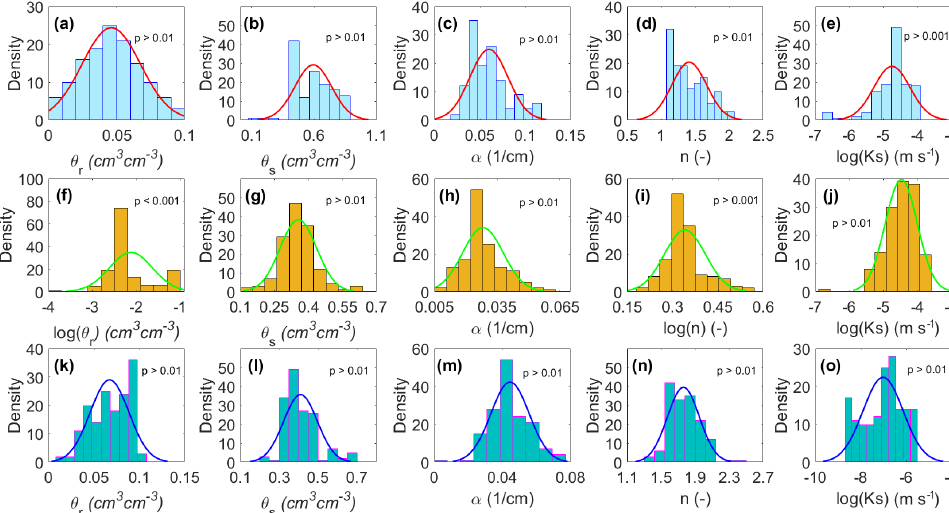
Figure 4. Probability density functions (PDFs) fitted to the four VG parameters and K s obtained from the IM for the three soil types: peat (a–e) , subsoil (f–j) , and LOS (k–o) . The mean and SD of the fitted distributions are shown in Table